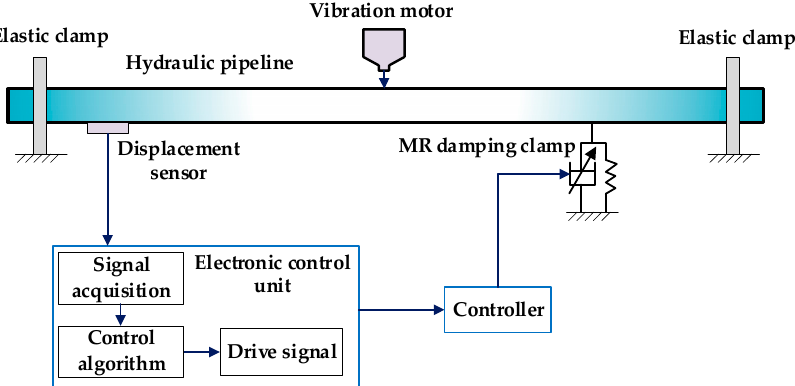
Figure 10. Schematic diagram of MR damper clamp pipeline vibration control